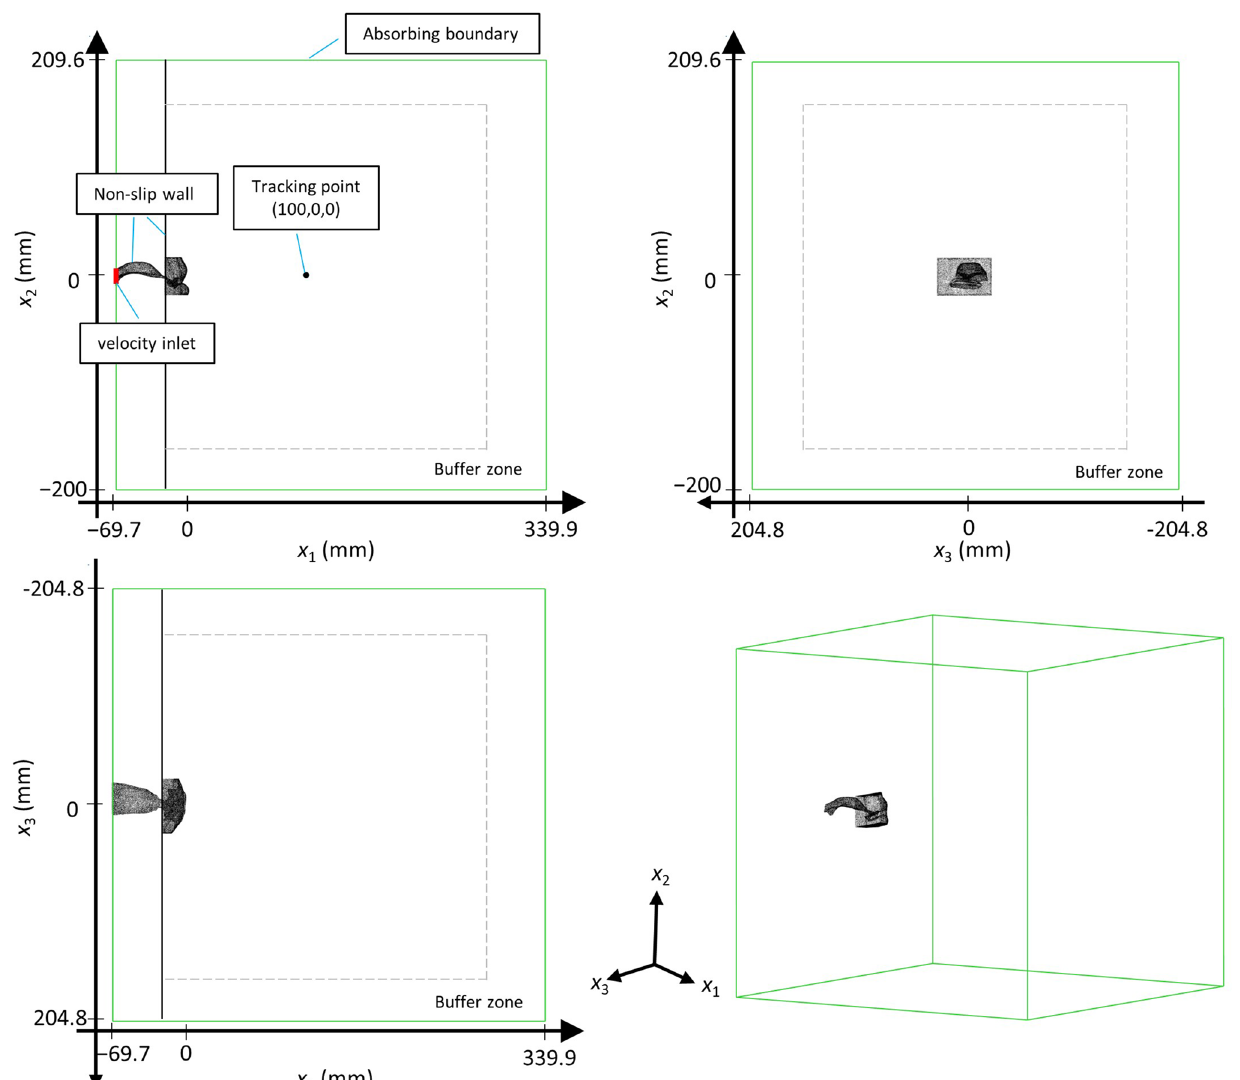
Figure 3. The three-view diagram of overall computational domain of the current